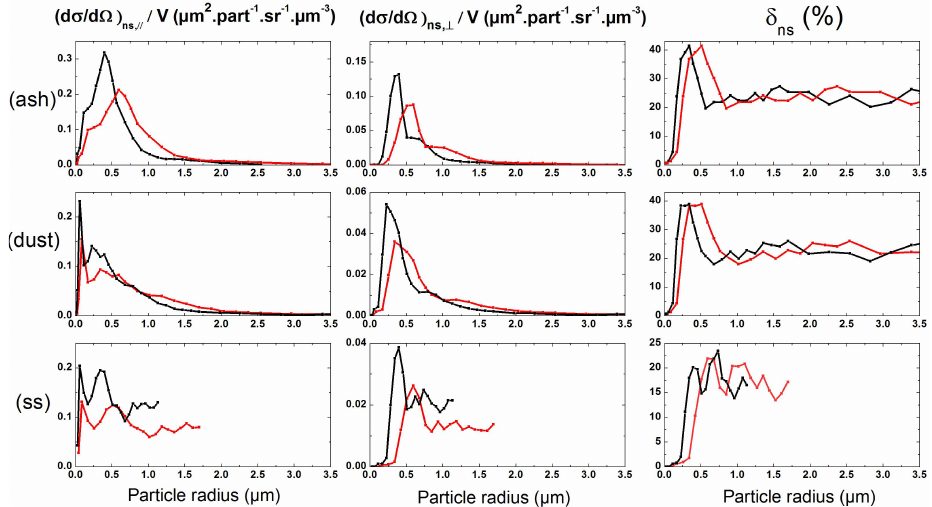
Fig. 2. Ns-particle backscattering cross section ( dσ / d(cid:127) ) ns ,// and ( dσ / d(cid:127) ) ns , ⊥ per particle volume and ns-particle depolarization ratio δ ns as a function of the particle radius r in the UV (black, λ 1 =355nm) and in the VIS (red, λ 2 =532nm) for each ns-particle type (ash, dust and sea salt (ss)).